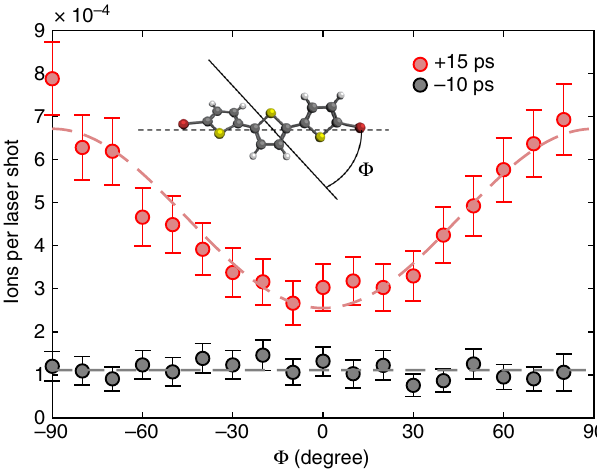
Fig. 4 Alignment-dependent strong- fi eld ionization of dibromoterthiophene. DBT molecules are 1D aligned by a linearly polarized alignment pulse and ionized by a linearly polarized probe pulse (same parameters as mentioned in the caption to Fig. 3). The yield of intact DBT + parent ions is measured as a function of the angle, Φ , between the polarization directions of the two laser pulses — illustrated on the sketch of the molecular structure. The measurements are performed at two times, around the peak of the alignment pulse ( t = − 10 ps) and in the fi eld-free window ( t = 15 ps). The dashed lines serve to guide the eye. Error bars represent the 95% con fi dence interval, assuming Poisson